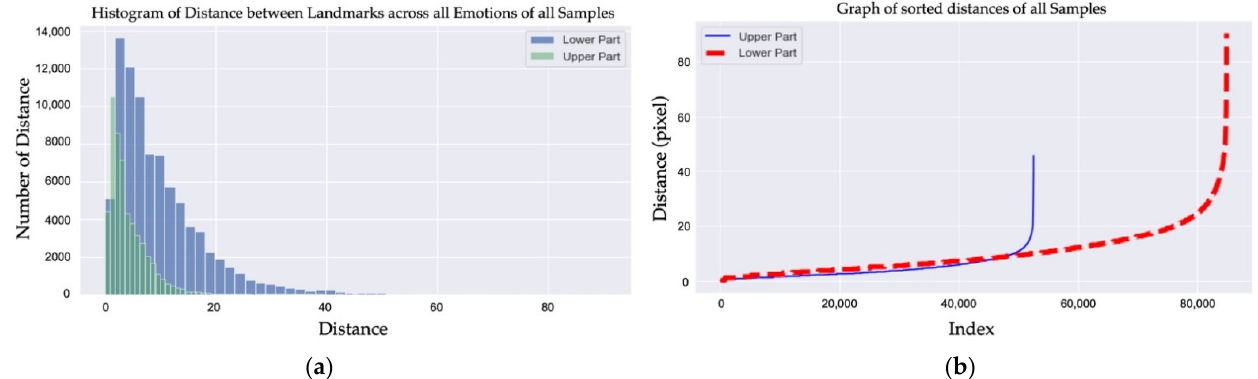
Figure 4. ( a ) Histograms of the distance between landmarks across all emotions from all of the samples in CK+; ( b ) graph of the sorted distances of all of the samples in CK+.